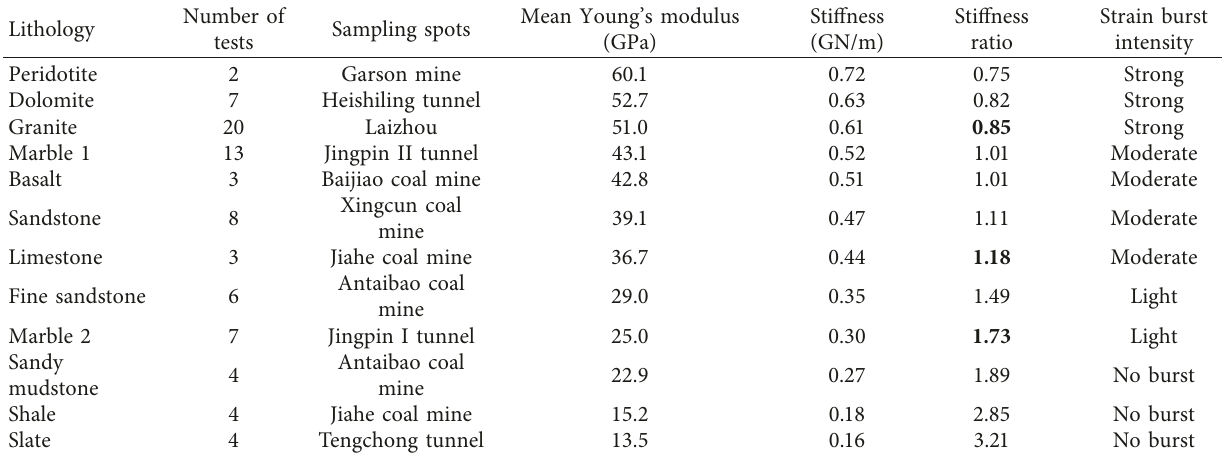
Table 5: Results of strain burst tests for different specimens.